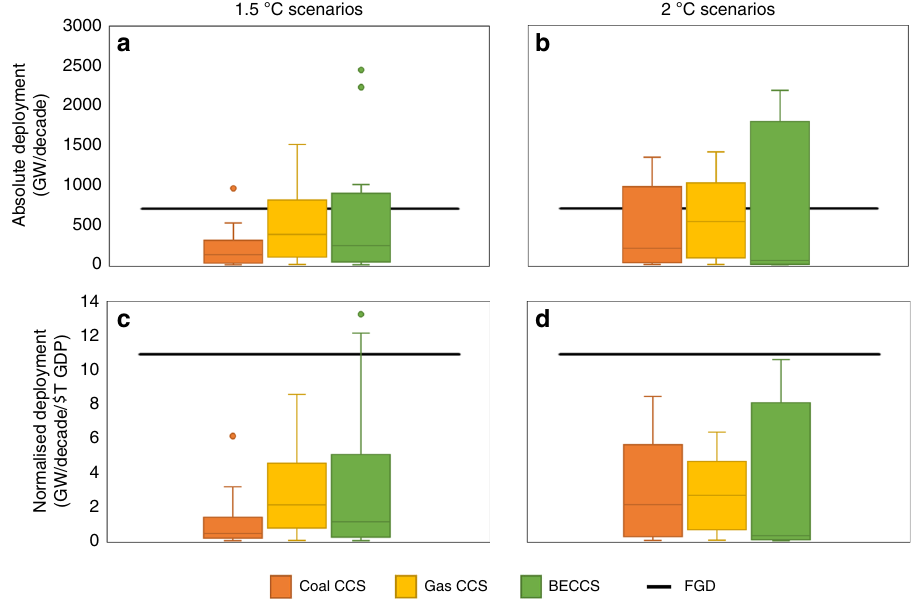
Fig. 5 Comparison of modelled and historical maximum deployment of CCS. The comparison includes coal, gas and bioenergy CCS (BECCS). Deployment of CCS is measured in absolute capacity ( a , b ) and capacity normalised by income ( c , d ). The modelled data are for 1.5 °C ( a , c ) and 2 °C ( b , d ) climate change scenarios. Sample sizes for the 12 box plots in a – d , reading each panel left to right: N = 33, 33, 23, 37, 33, 27, 33, 33, 23, 37, 33, 27. Boxes show the median and interquartile ranges of scenario data. Whiskers show min/max values that lie within 1.5 times the interquartile range, and scenarios outside this range are plotted as outliers. An outlier is excluded from the 2 °C scenarios of coal CCS — the IMACLIM AMPERE 450 scenario reached >4000 GW/ decade (absolute), and >36 GW/decade/$T GDP (normalised). The 1.5 °C scenarios are taken from the IMAGE, REMIND and AIM/CGE models; 2 °C scenarios include these, and also scenarios from DNE21, POLES, MESSAGE, MERGE-ETL, WITCH and IMACLIM. Source data are provided as a Source Data fi